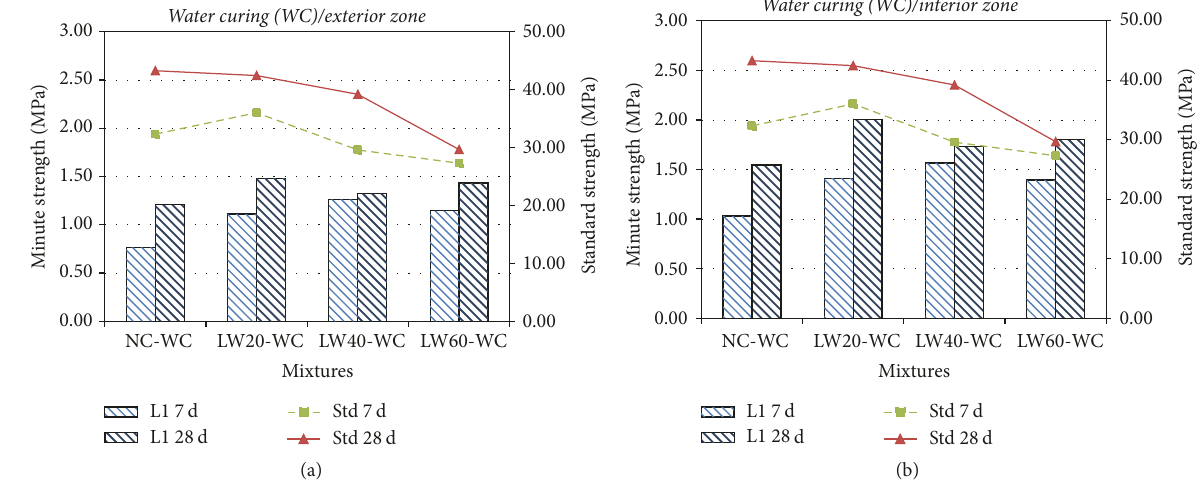
Figure 16: Relationship between standard and minute compressive strength of water curing regime at (a) exterior zone and (b) interior